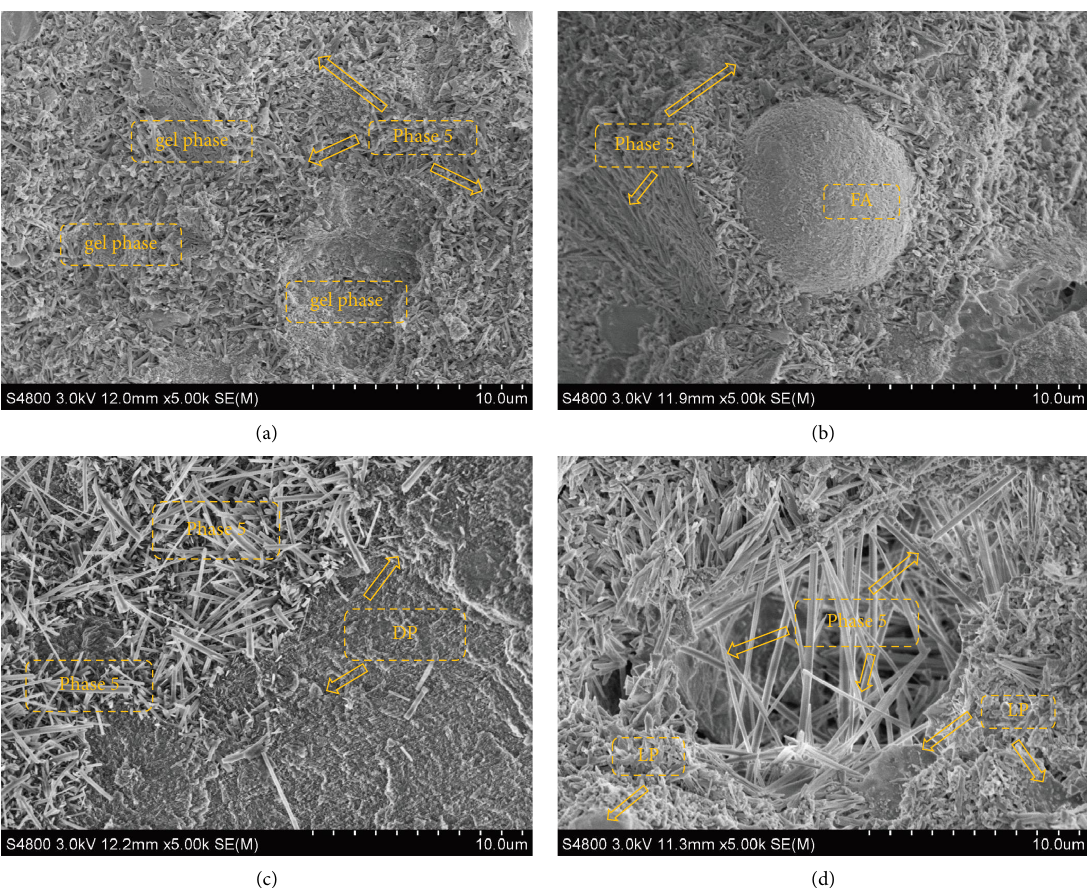
Figure 6: SEM image of MOCLC with mineral admixture. (a) SEM image of MOCLC. (b) SEM image of MOCLC-FA. (c) SEM image of MOCLC-DP. (d) SEM image of